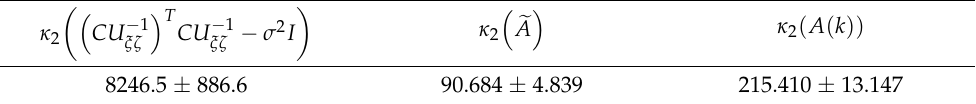
Table 1. The mean values of the condition numbers of the matrices and their standard